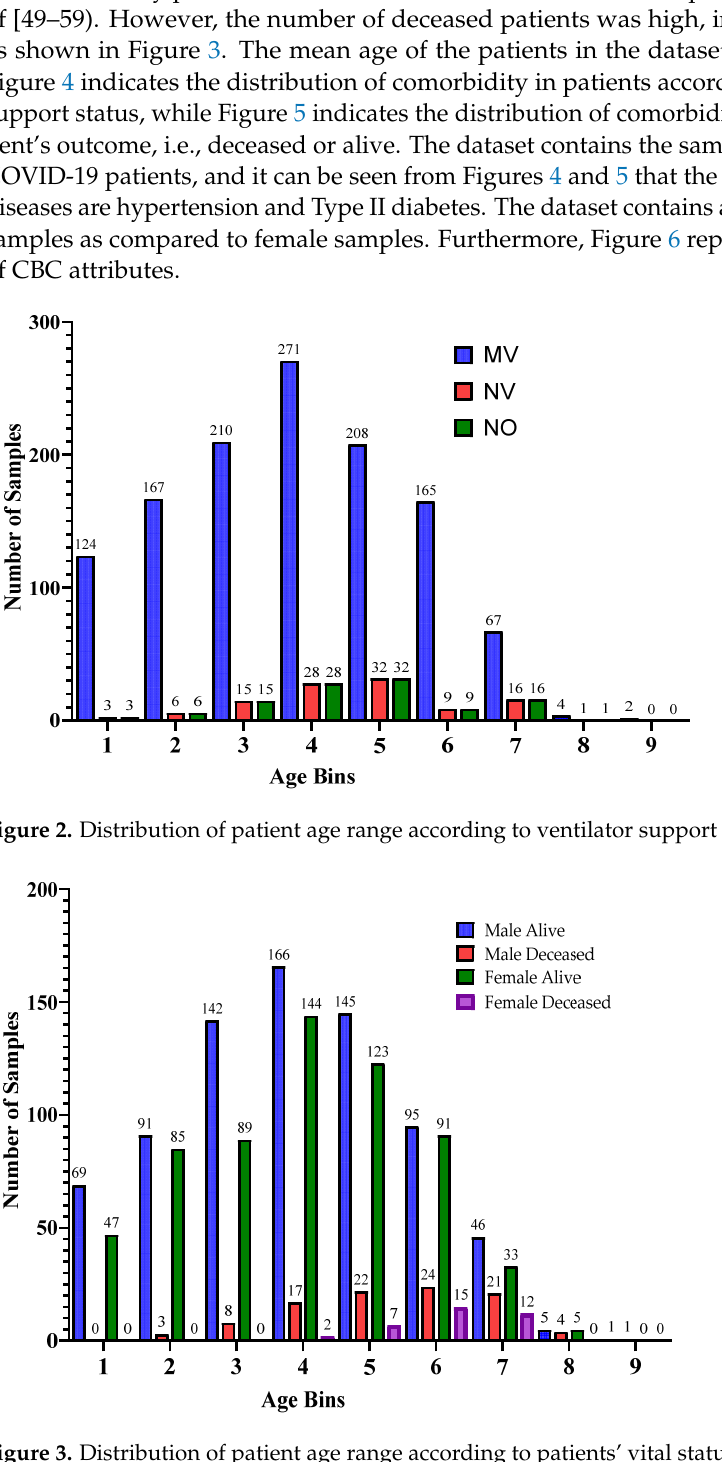
Figure 3. Distribution of patient age range according to patients’ vital status.